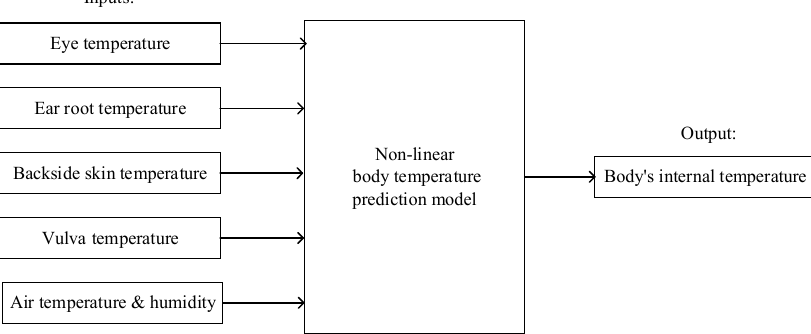
Figure 2. The inputs and output of the prediction model incorporating environmental factors.